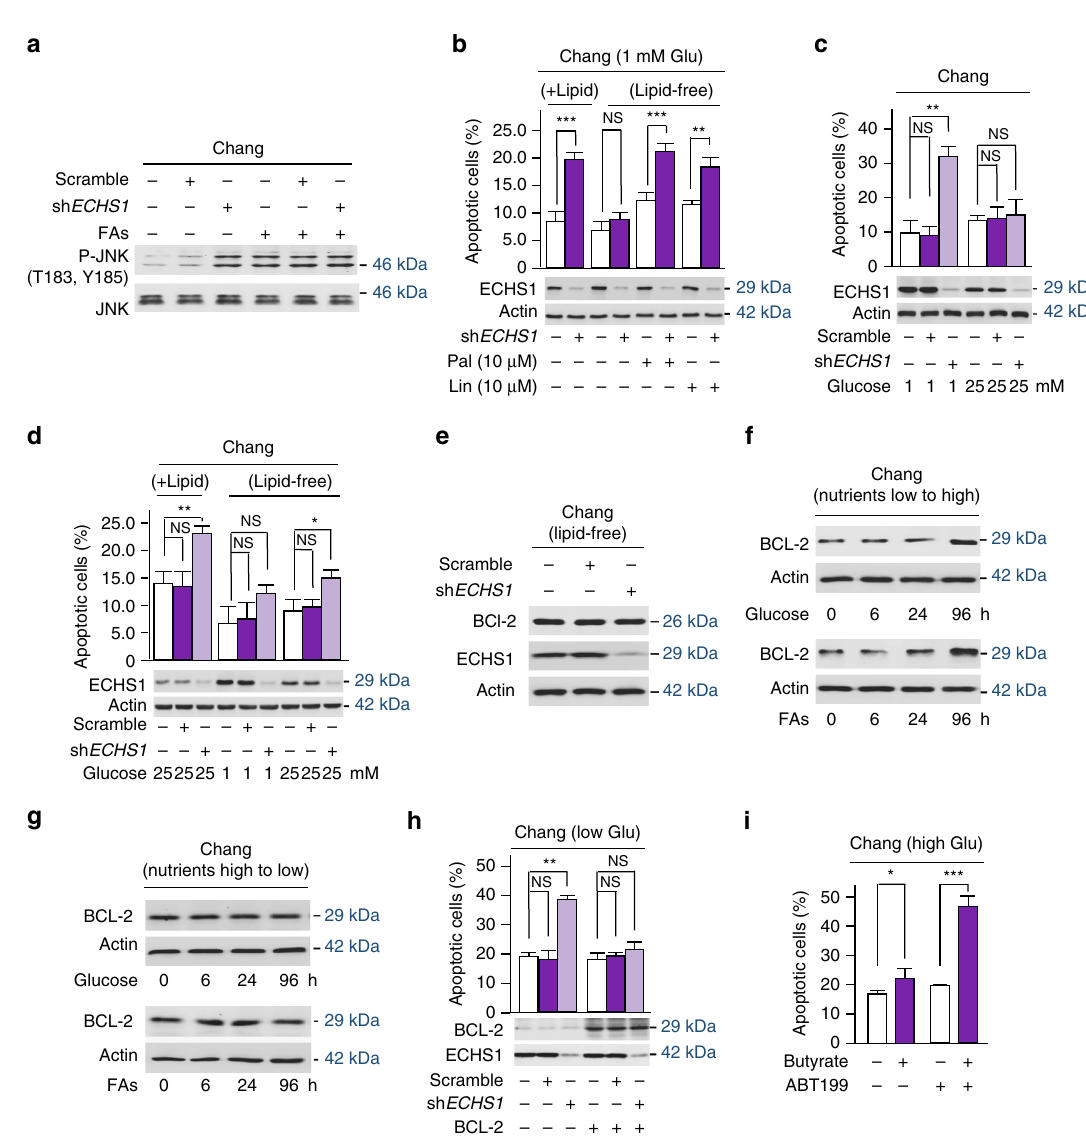
Fig. 9 Nutrient induces apoptosis resistance. a The p-T183 and p-Y185 levels of JNK were analyzed for their responses to ECHS1 knockdown in Chang cells cultured in DMEM media with and without fatty acids supplementation. b The apoptotic rates of Chang and ECHS1 knockdown Chang cells that were cultured under presence and absence of lipids, and lipid-free media supplemented with saturated palmitate or unsaturated linoleic acid, were determined ( n = 4). c The percentages of apoptotic Chang cells and apoptotic ECHS1 knocked down Chang cells were determined when cells were cultured in the presence of 1 mM and 25 mM glucose ( n = 4). d The apoptotic rates of Chang and ECHS1 knockdown Chang cells that were cultured under presence and absence of lipids, and lipid-free media supplemented with low and high glucose, were determined ( n = 4). e BCL-2 levels in Chang cells and ECHS1 knockdown Chang cells that were cultured in lipid-free media were compared. f Chang cells were conditioned in glucose- or fatty acids-free media for 24 h before they were transferred to media containing high glucose (25 mM) or high fatty acids (250 nM), BCL2 levels were monitored over time. g Chang cells were conditioned in high glucose or high fatty acids for 96 h before they were transferred to low glucose (1 mM) or low fatty acids (250 nM) media, BCL2 levels were monitored over time. h The apoptotic rates in Chang cells and ECHS1 knockdown Chang cells cultured under low glucose were determined under with and without BCL-2 overexpression. i Chang cells were cultured in the presence of 25 mM glucose. The percentages of apoptotic cells of untreated and 1 mM butyrate-treated cells with or without ABT-199 treatment were determined ( n = 4). For all fi gures, mean values with SD are reported. not signi fi cant; * P < 0.05; ** P < 0.001; *** P <